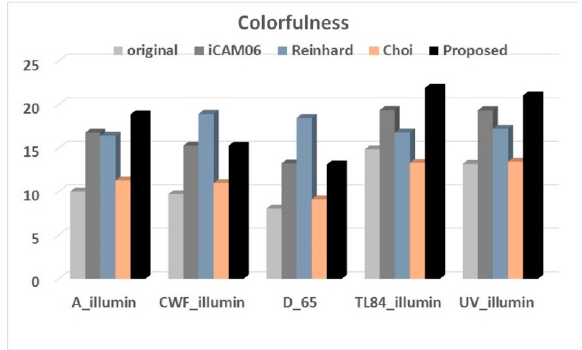
Figure 12. CIEL*a*b*-based colorfulness comparison between the conventional and proposed tone mapping methods with the captured images under five standard illuminations. Appl. Sci. 2019 , 9 , x FOR PEER REVIEW